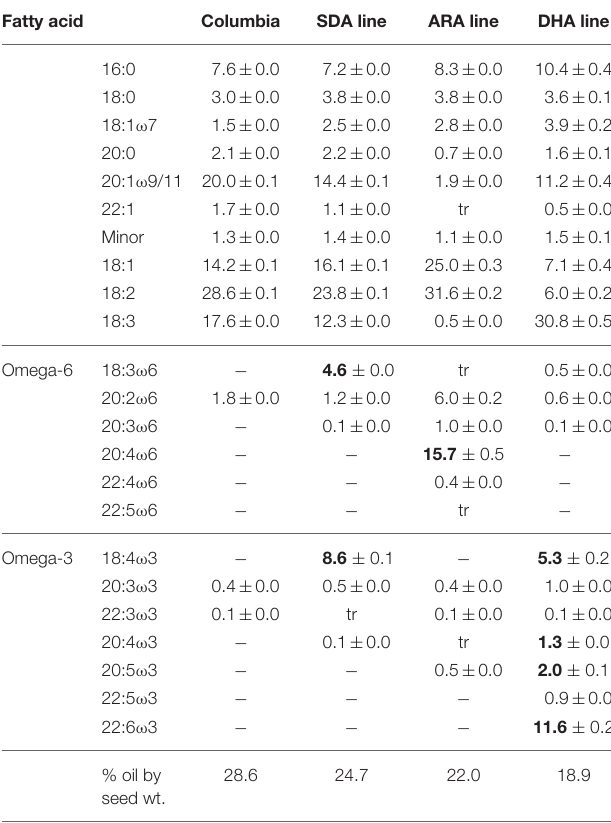
TABLE 1 | Oil content and fatty acid profiles in wild type and transgenic lines of Arabidopsis seeds. Fatty acid Columbia SDA line ARA